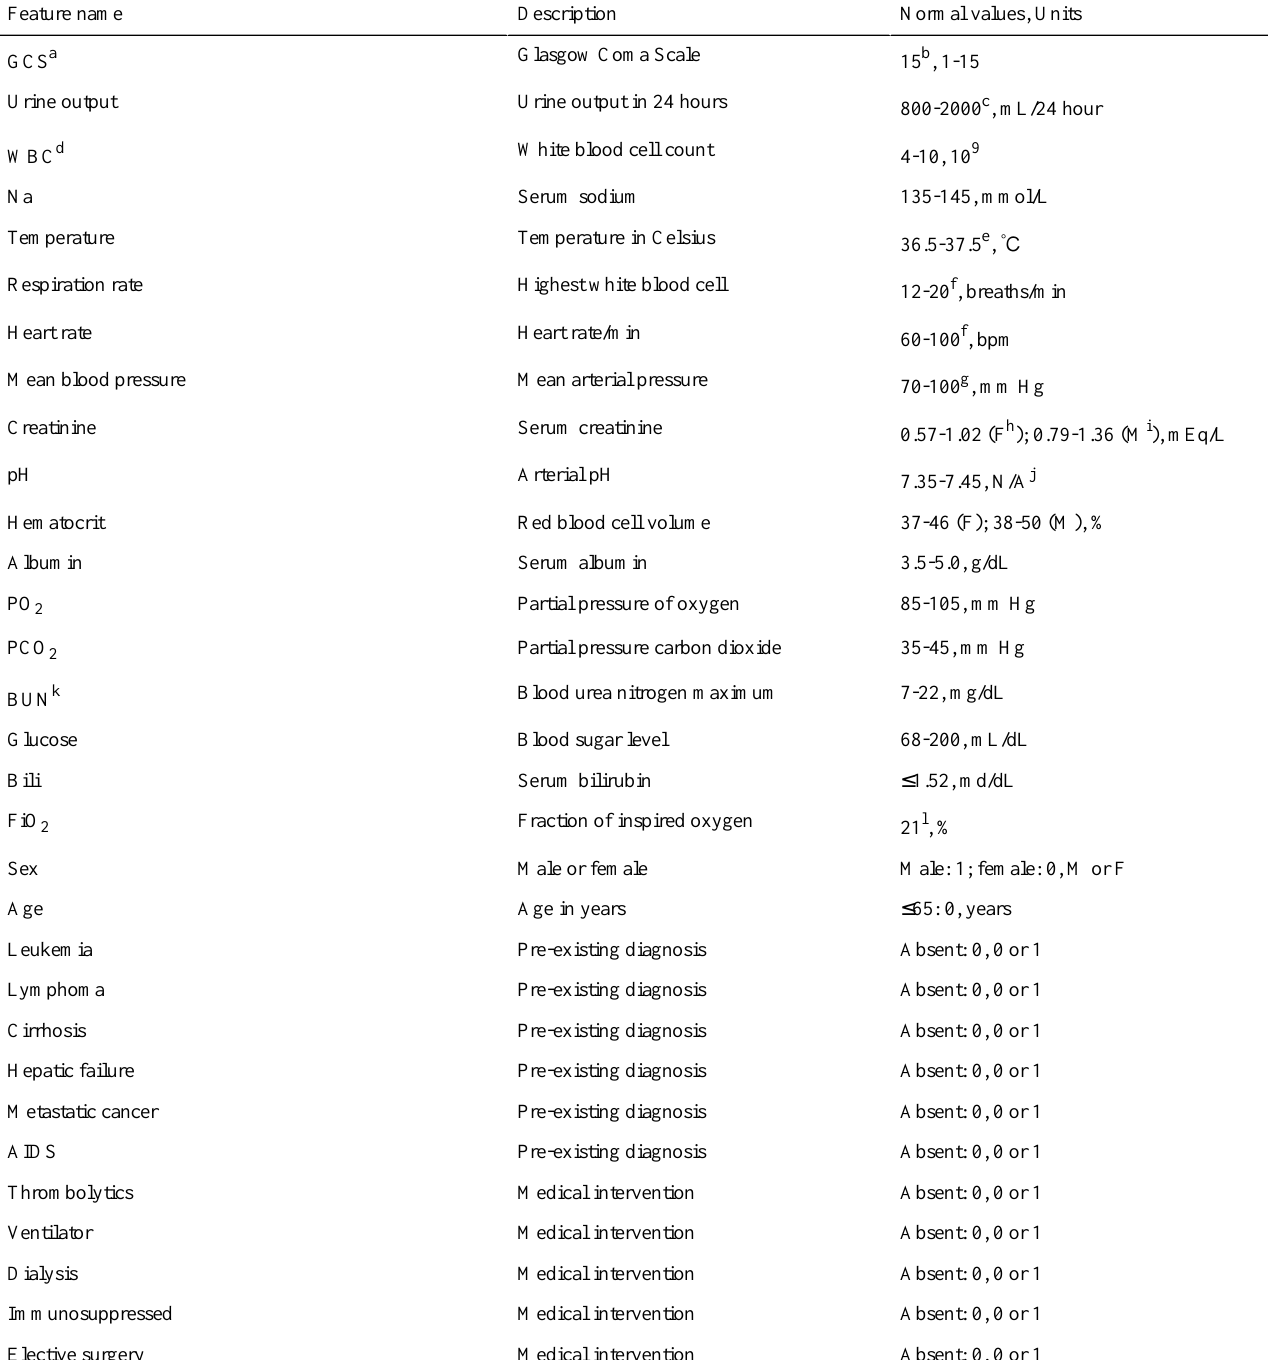
Table 2. Electronic intensive care unit data set variables based on Acute Physiology and Chronic Health Evaluation